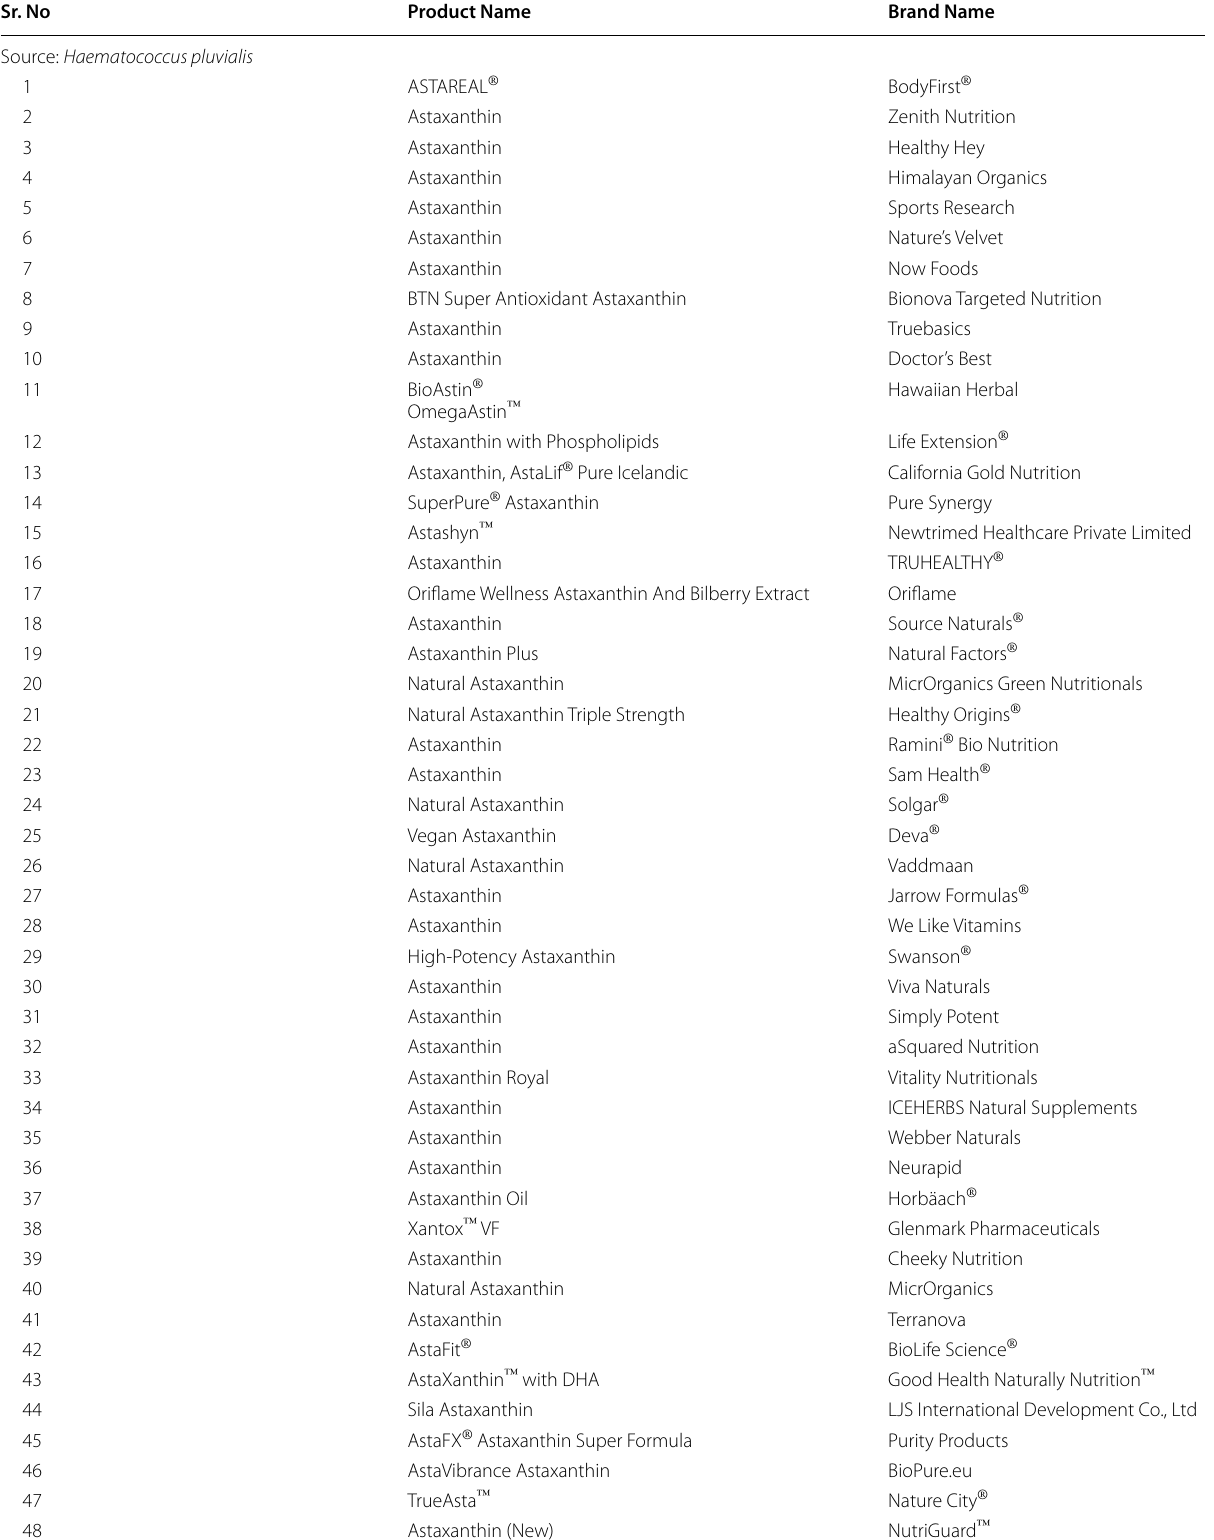
Table 2 Astaxanthin (as a nutraceutical) manufacturing global brands (from different biological sources) Sr.